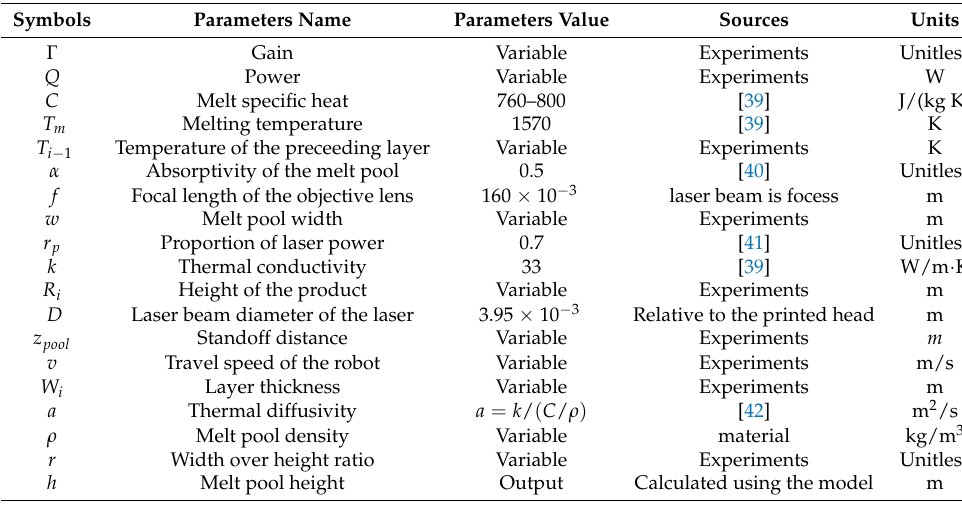
Table 2. Process variables and material properties of Inconel 718.